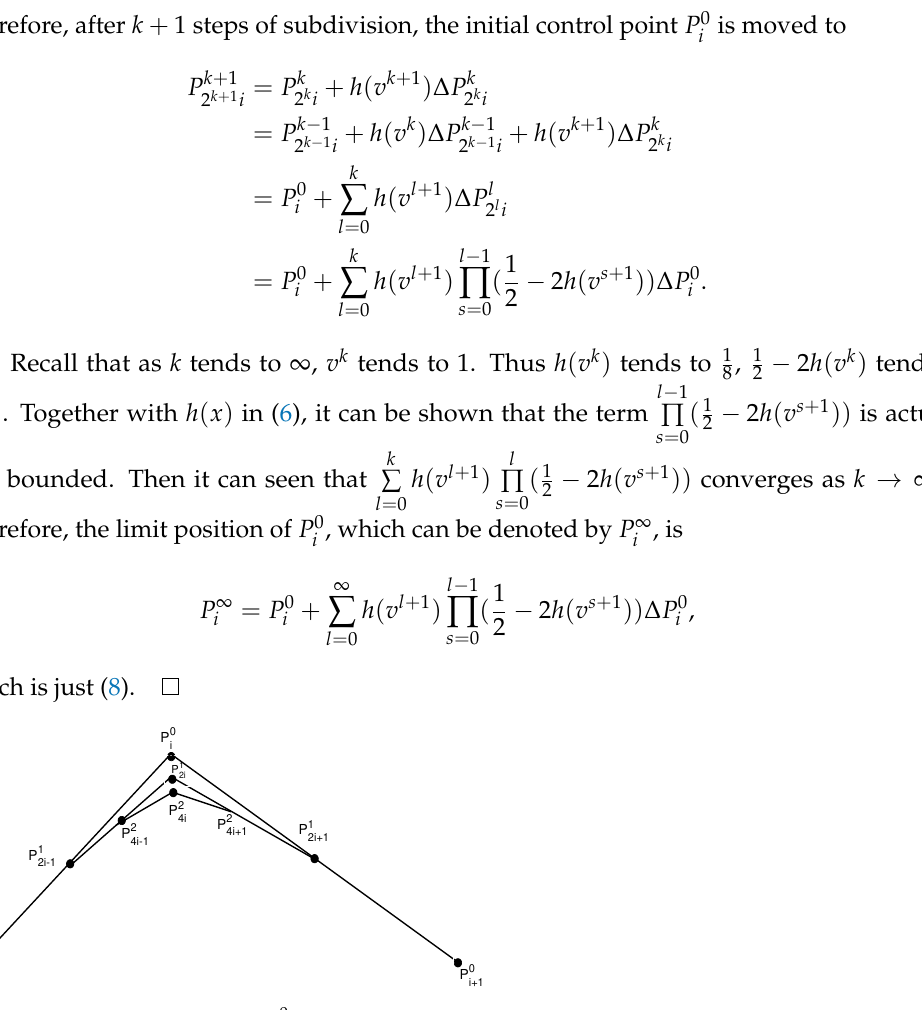
in the first two steps of i